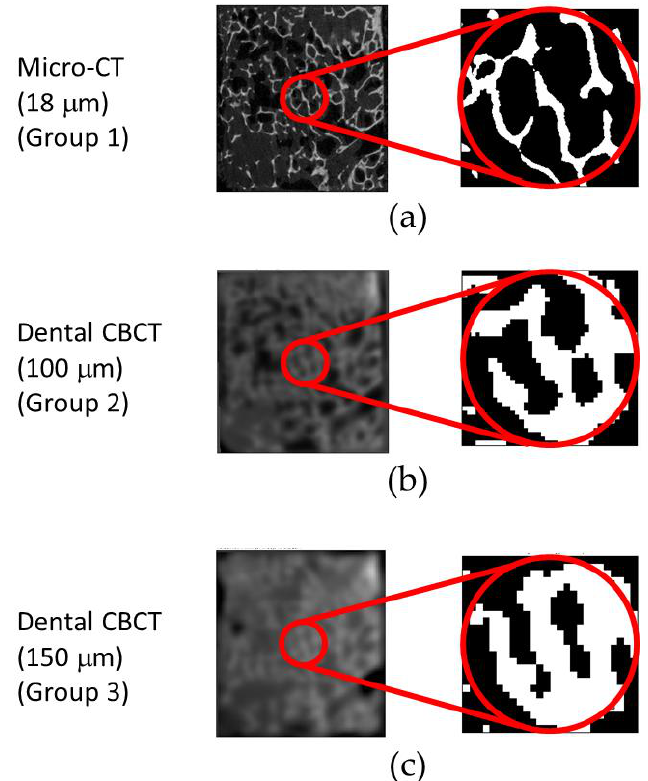
Figure 1. Original and binary images of regions of interest (ROI) from the two scanning methods: ( a ) micro-CT image; ( b ) 100 µ m resolution dental CBCT image; ( c ) 150 µ m resolution dental CBCT image.